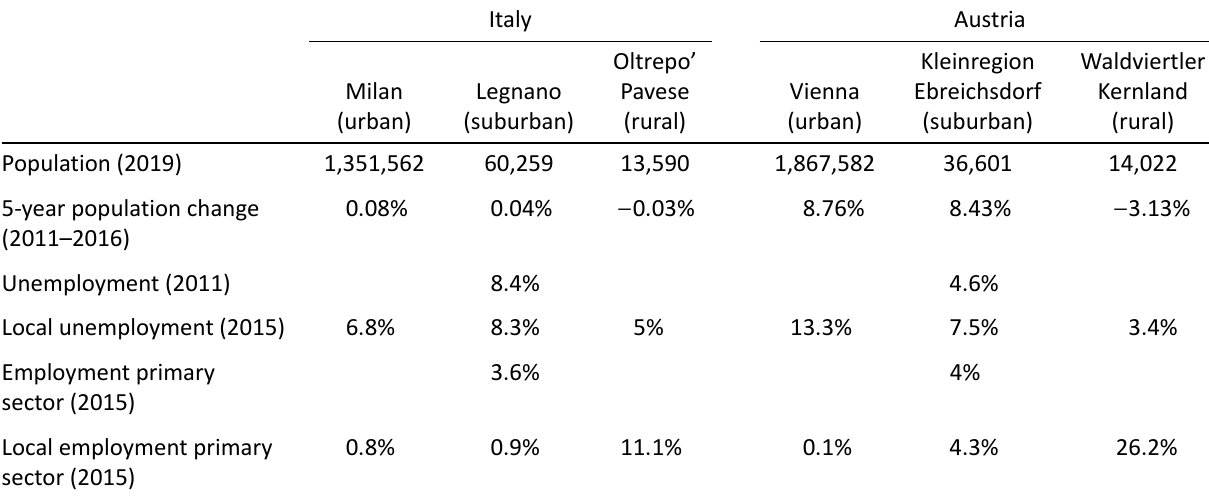
Table 1. Main features of the selected